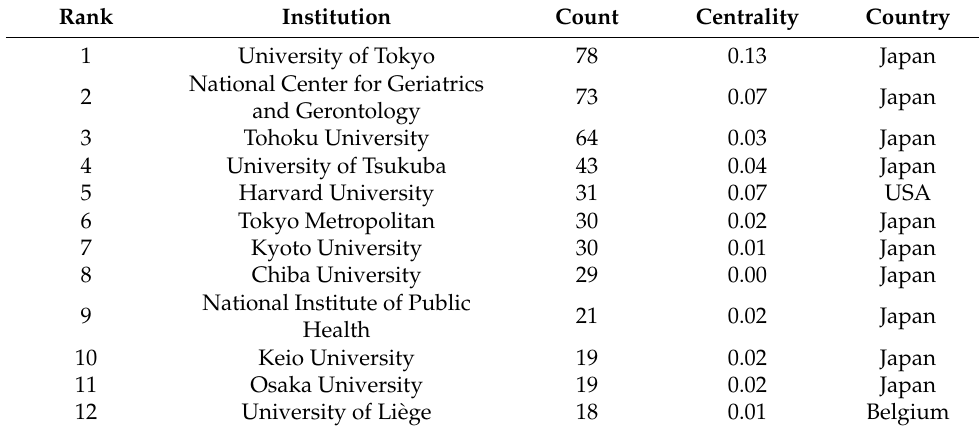
Table 2. Top 12 productive